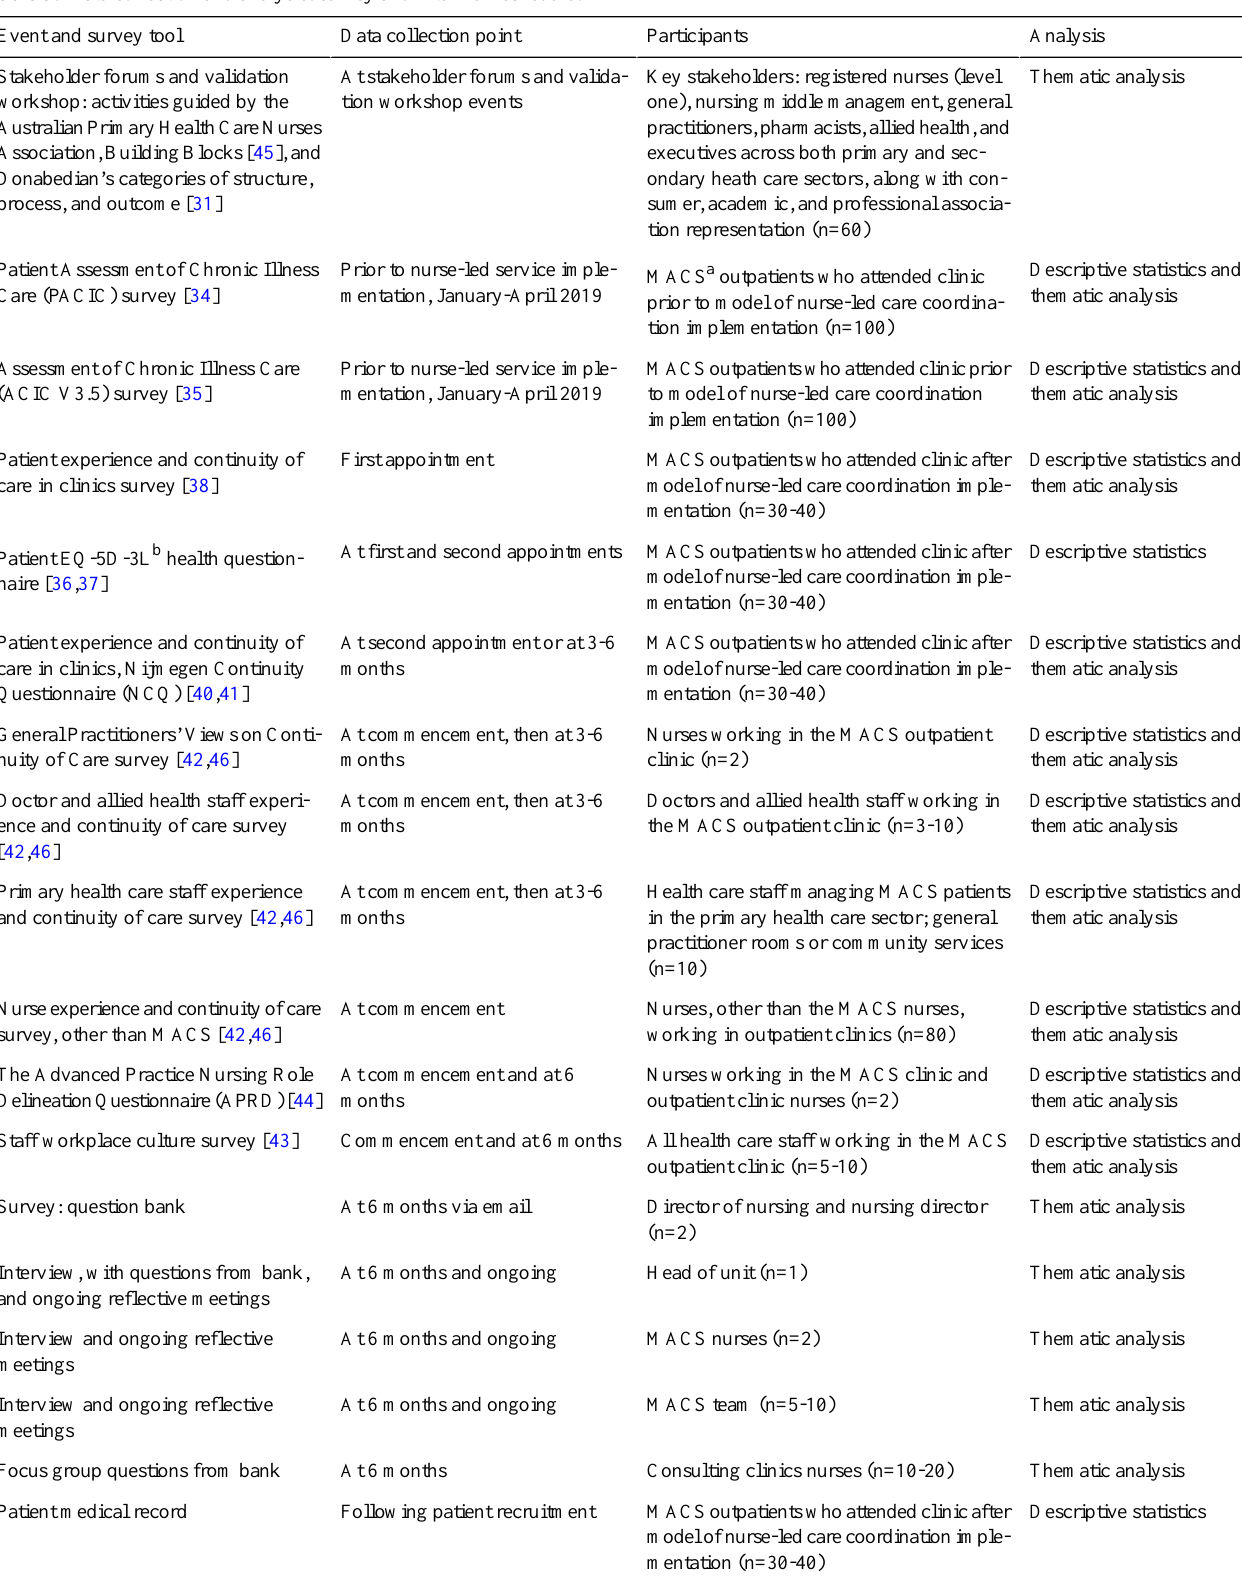
Table 3. Data collection and analysis: survey and interview